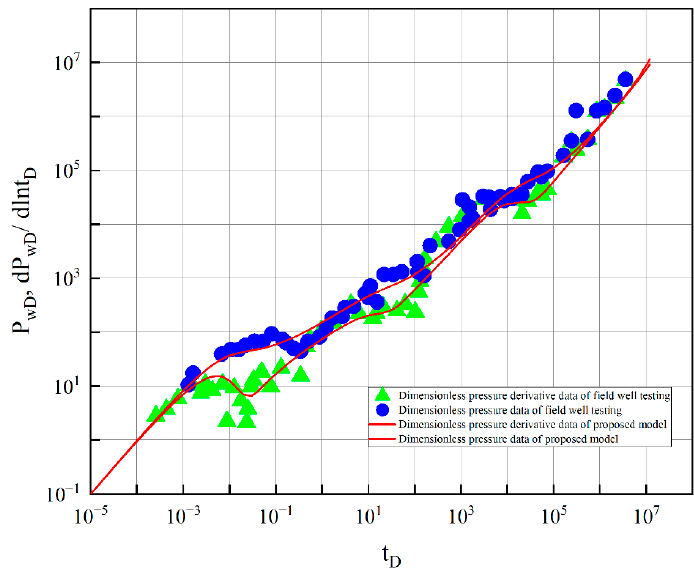
Figure 6. Model validation and